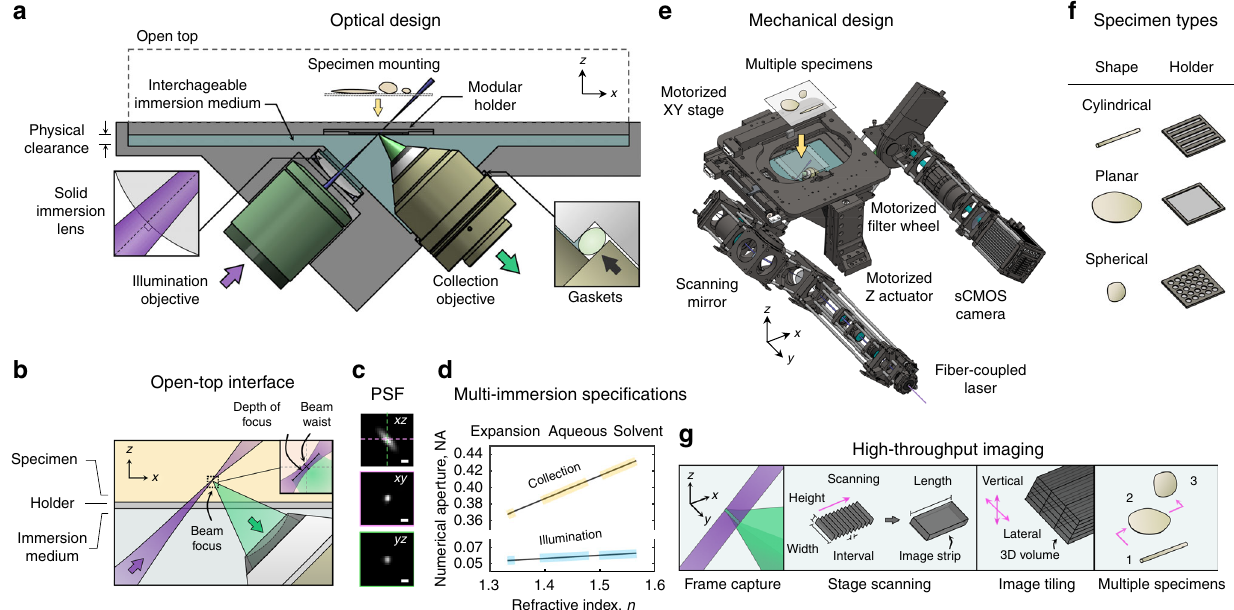
Fig. 1 Multi-immersion open-top light-sheet (OTLS) microscope. a The system enables simple mounting of multiple specimens with modular transparent holders. Illumination and collection objectives are located underneath the specimen holders and are separated by a liquid reservoir fi lled with an interchangeable immersion medium. b The off-axis illumination light sheet and collected fl uorescence travel obliquely through the immersion media, holder, and specimen. Aberrations are minimized by precisely matching the refractive index of all three materials, and by utilizing the wavefont-matching properties of a solid-immersion lens (SIL) along the illumination path. The depth-of-focus and beam waist of the light sheet are depicted in the inset (upper right). The point spread function (PSF) of the system (scale bars: 1 μ m) and refractive-index-dependent numerical aperture (NA) of the illumination and collection beams are shown in ( c ) and ( d ). e The mechanical design of the system includes a motorized XY stage, motorized Z actuators, motorized fi lter wheel, scanning mirror, computer-controlled multi-wavelength fi ber-coupled laser package, and sCMOS camera, all of which enable high-throughput automated imaging of multiple specimens simply placed on a fl at plate, or placed within a diverse assortment of transparent holder designs ( f ). g Volumetric imaging is achieved by using a combination of stage scanning and lateral/vertical